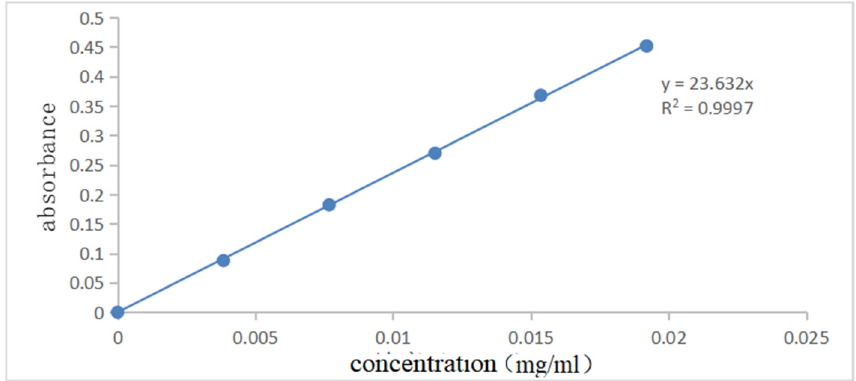
Figure 7. Standard curve of UV spectral absorption of MO (460 nm).